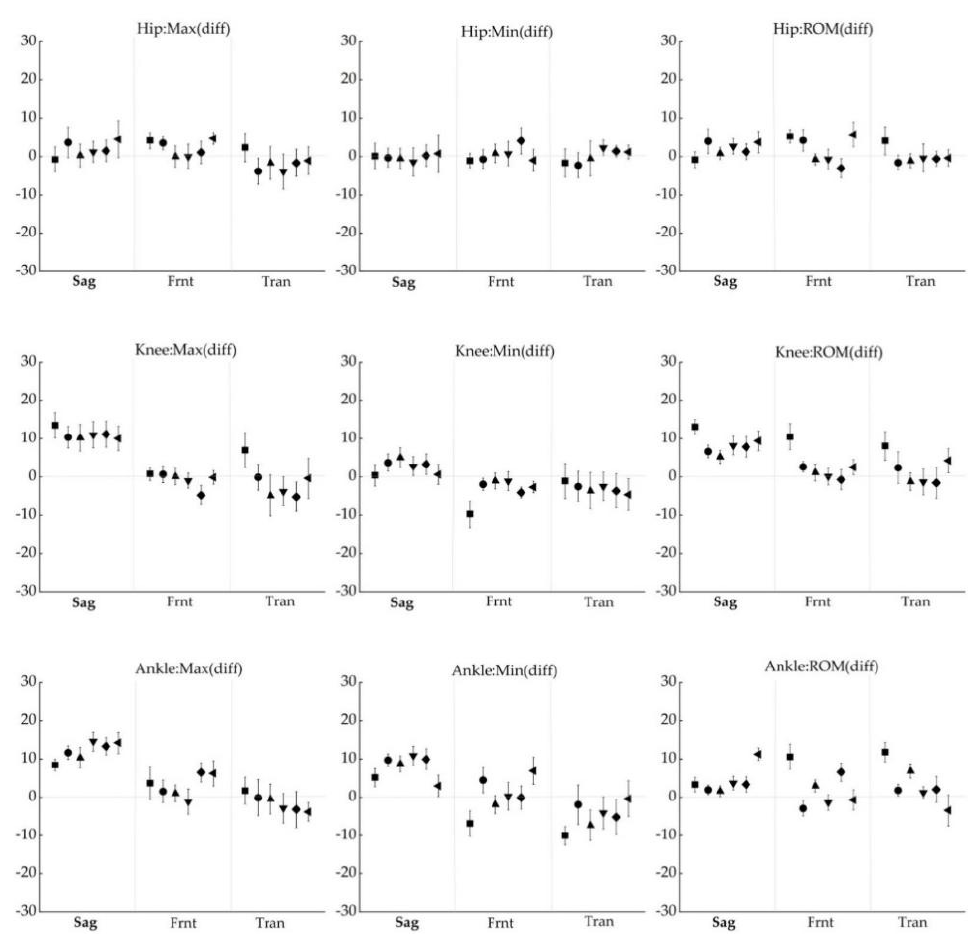
Figure 7. Difference between IMU suit and OptiTrack system in minimum angle (left row), maximum angle (center row), range of motion (right row). The six data points of each plane correspond to the GA ( ■ ), SQ ( ● ), SLS ( ▲ ), FL ( ▼ ), SL ( ◆ ), and CMJ ( ◄ ). Positive numbers showed that the angle calculated by the Perception Neuron ® system was larger than the angle computed by the OptiTrack system. The error bars represent the 95% confidence interval of the difference.